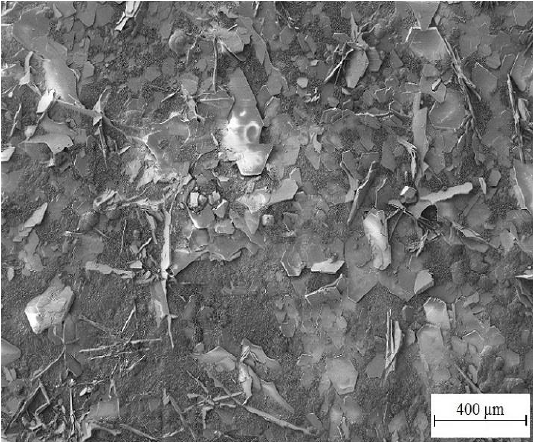
Figure 14. Morphology of precipitated corrosion products on HDG after 3 months’ exposure in simulated concrete pore solution of pH 12.8 without KMnO 4 .